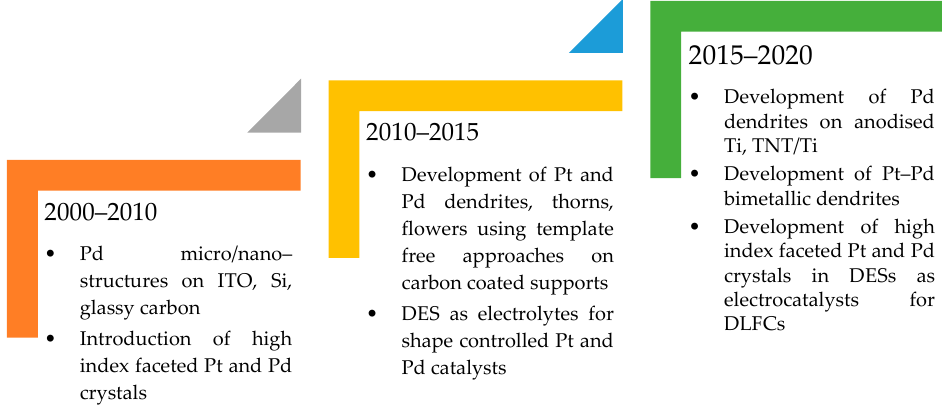
Figure 9. Progress in the developments of shape controlled noble metal (Pt, Pd) structures synthesised by electrodeposition covering the period 2000–2020.